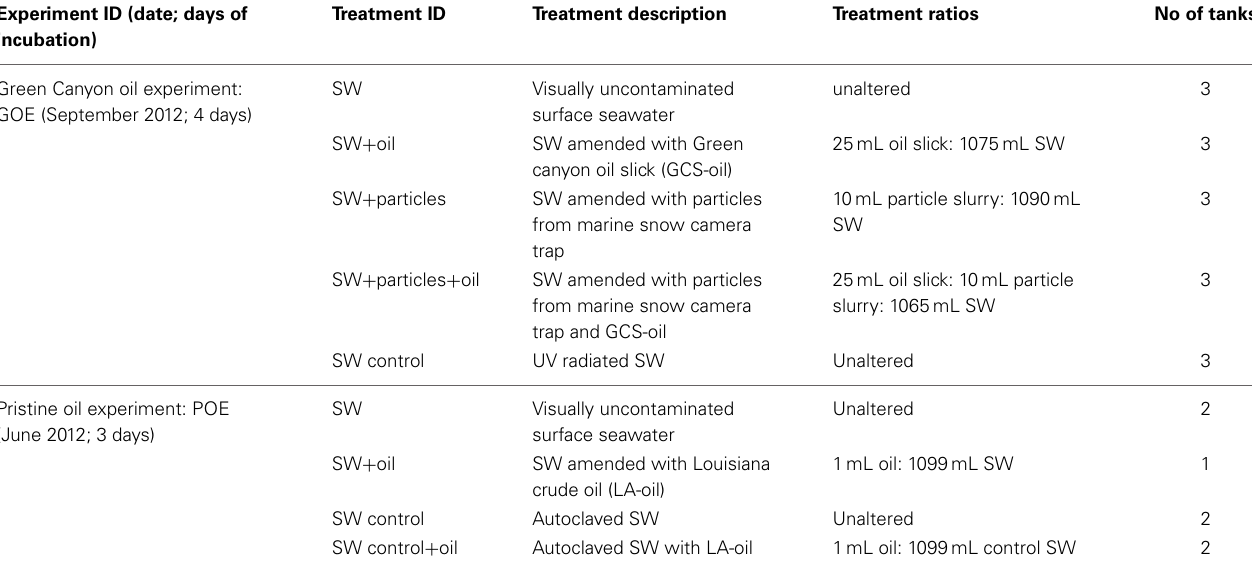
FIGURE 1 | Map of investigation area. Oil slick samples were taken at GC 600. Sinking particles for SW + particles and SW + particles + oil treatments were sampled near the bottom of Table 1 | Experimental set-up of the two onboard roller tank